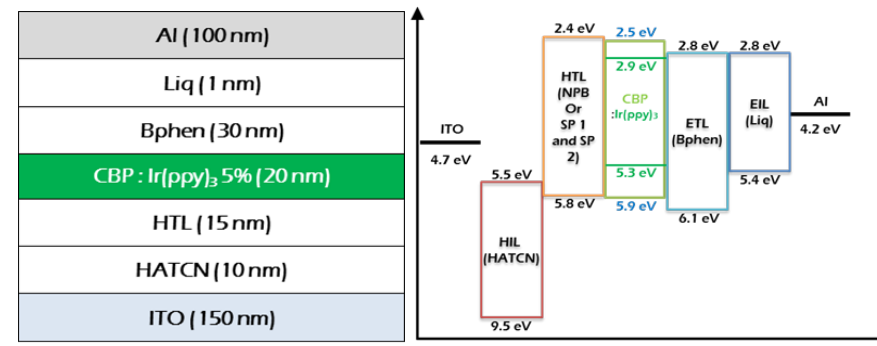
Figure 7. The OLED device structure and energy diagram of fabricated green devices.